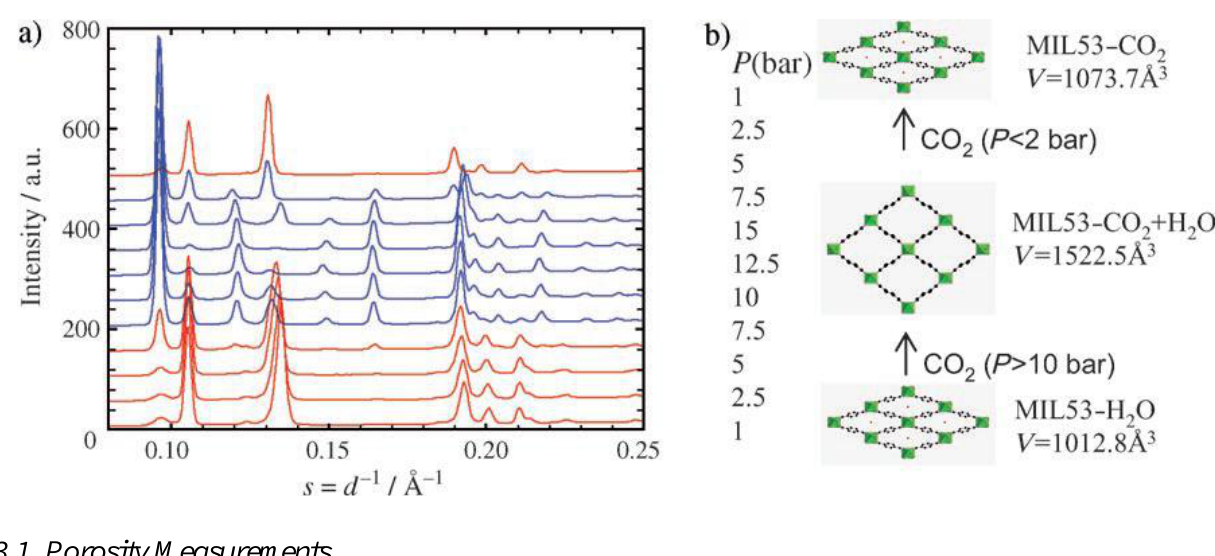
Figure 10. ( a ) The illustration of structural change of hydrated MIL-53(Cr) using in situ X-ray diffraction with respect to the pressure cycle of CO corresponding breathing behavior of MIL-53(Cr). Reprinted with permission from